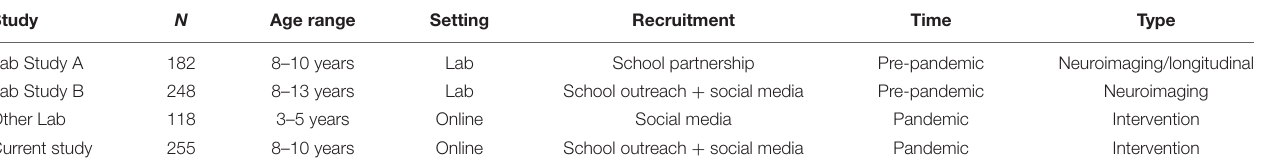
TABLE 1 | Comparison to three representative